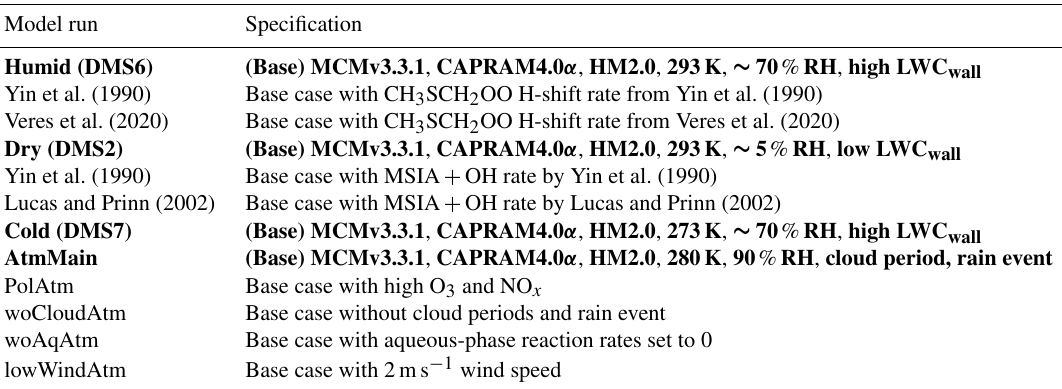
Table 3. Overview of conditions used in the model base runs (rows in bold) and sensitivity runs (rows in roman) in both chamber and atmospheric relevant simulations.